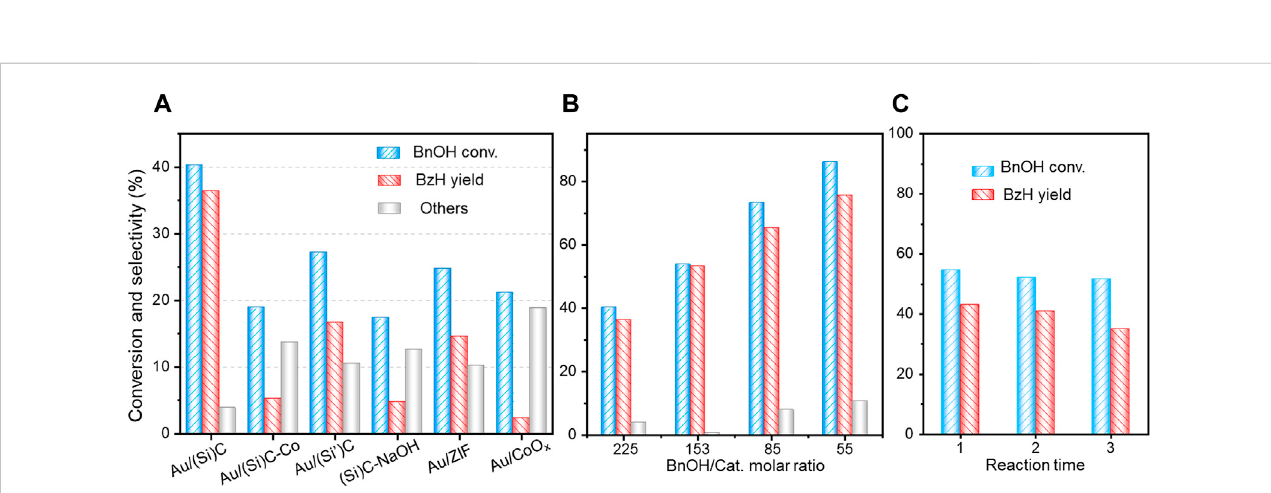
FIGURE 5 (A) Catalytic performances ofalkali-free BnOH oxidation via thederived Au/(Si)C anddifferentreferences. (B) BnOH conversion as afunction ofreaction time. (C) StabilitytestofAu/(Si)C.Reaction conditions:ABnOH/Aumolarratioof225with30 mgcatalystwasusedin (A) forbettercomparison(20 ml/minO 2 fl ow, 80 ° C for 4 h). A BnOH/Au molar ratio of 486 with 7 mg catalyst was used in (C) to understand the catalytic stability under limited catalyst dosage.